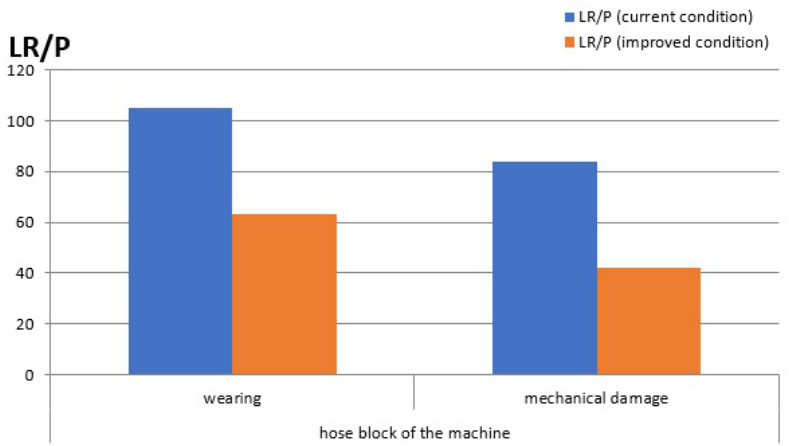
Figure 6: FMEA results for hydraulic system of harvester John Deere 1070D